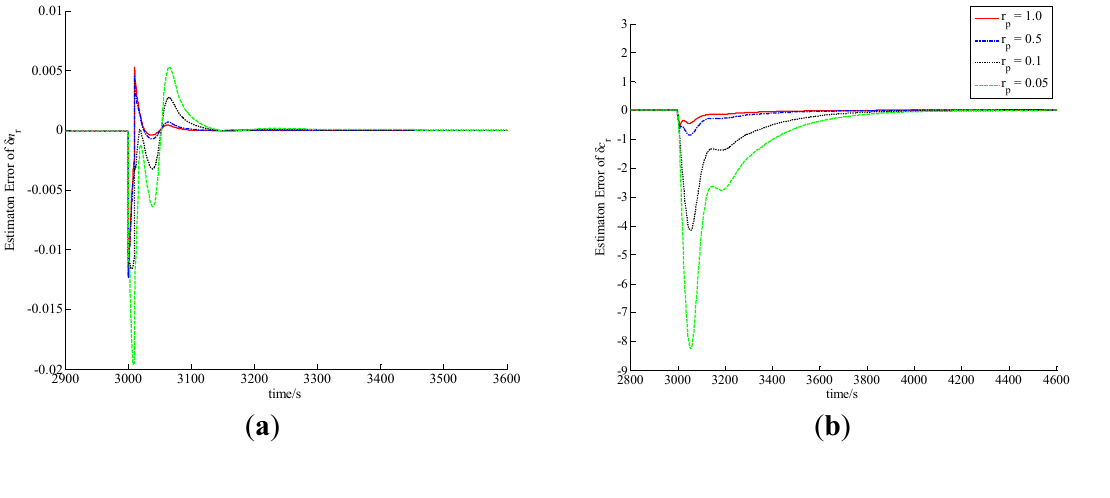
Figure 2. Observation errors of ( a ) δ n